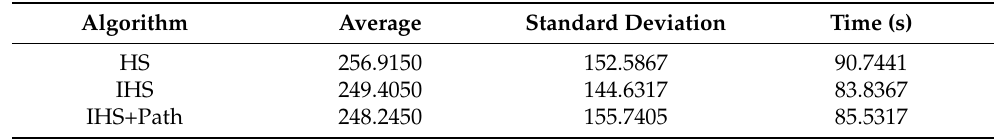
Table 3. Convergence analysis results for the 33-bus test